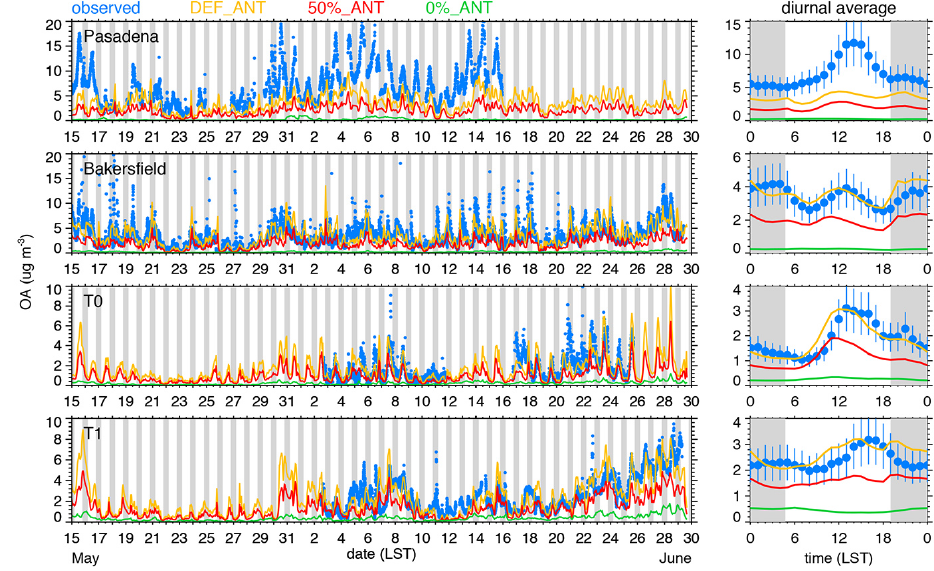
Figure 12. Observed (AMS instrument) and simulated time series (left panels) and average diurnal variation (right panels) of OA at the four supersites. Simulated OA is the total of the first four model size bins up to 0.625µm diameter. Gray shading denotes night and vertical lines in right panels denote measurement uncertainty range. 50%_LBC simulation results not shown since they are nearly identical to those from the 50%_ANT